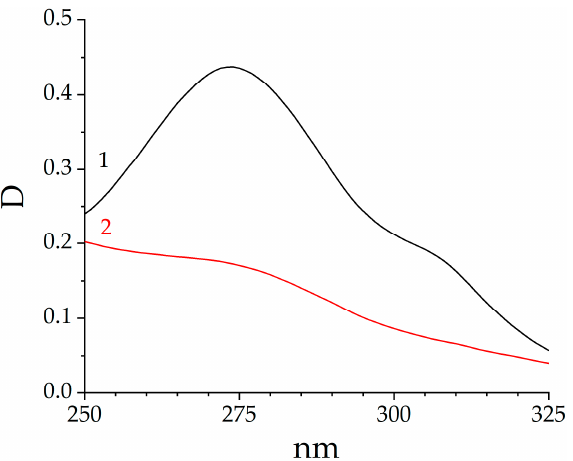
Figure 2. UV spectra of the acetylacetonate solution ( 1 ) and the vanadyl alkoxoacetylacetonate solution ( 2 ) prepared as a result of its heat treatment for 18